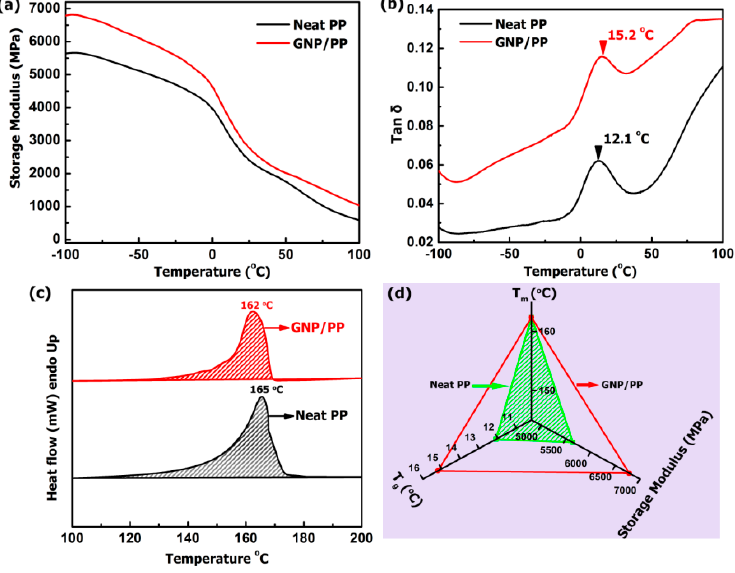
Figure 5. ( a ) Storage modulus ( b ) loss factors ( c ) DSC curves and ( d ) radar chart presentation of three parameters of the PP and GNPs/PP composites.